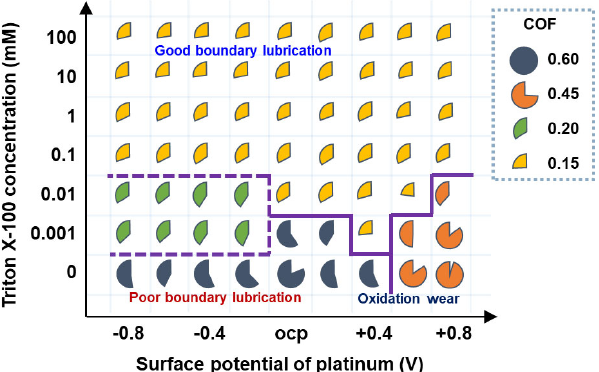
Fig. 10 Friction map of Pt/ZrO 2 tribo-pairs lubricated with different concentrations of Triton X-100 aqueous solutions under different surface